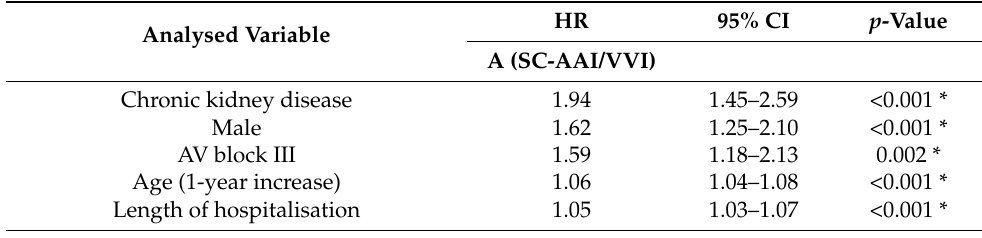
Table 3. Multivariate analysis showing the factors affecting survival in three groups: A (SC-AAI/VVI), B (DC-DDD), and C (ICD/CRT).